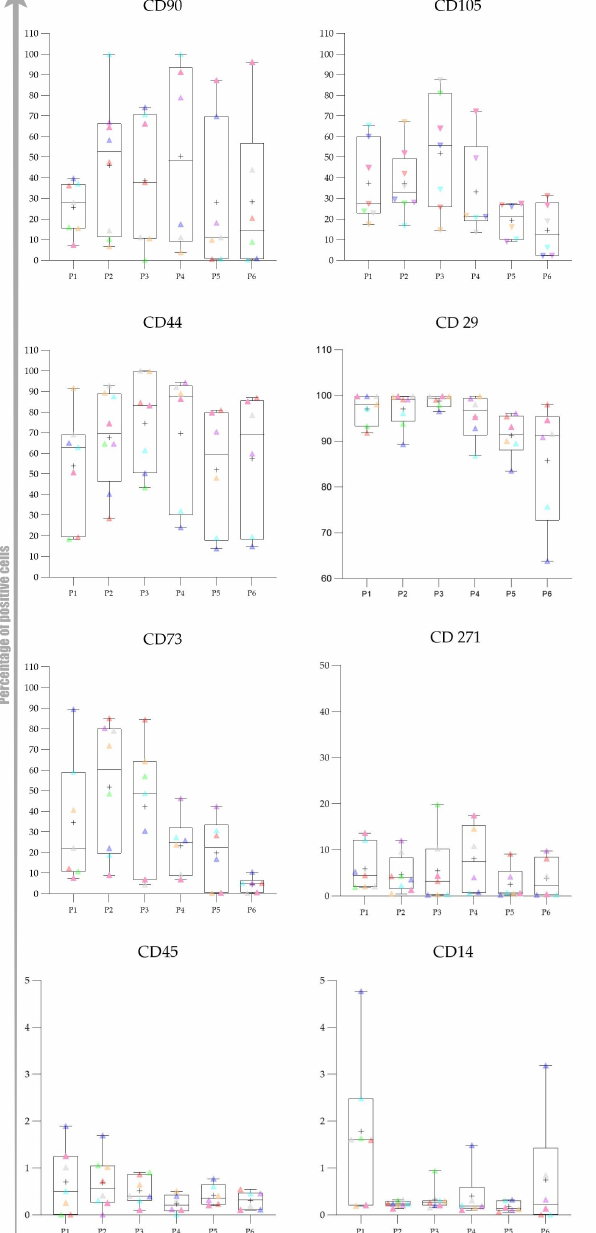
Figure 5. Changes in the percentage of positivity of canine adipose-derived mesenchymal stem cells (cAD-MSCs) during in vitro cultivation. The results are based on eight biological replicates, young female canines referred to an elective surgery procedure with no obvious signs of disease. Flow cytometry assessment of surface marker positive cAD-MSCs showed no statistically significant changes in the percentage of positive cells for the following markers: CD90, CD44, CD29, CD105 and CD271. Statistically significant changes were observed for CD73 between early (P1–P3) and late (P4–P6) passages. The X -axis represents the passage number (from P1 to P6), whereas the Y -axis displays the average positivity percentage. The Whisker box plot was created to present the dynamics of changes between passages. Centerlines denote the median, plus the mean, box limits indicate the twenty-fifth and seventy-fifth percentiles; whiskers represent the maximum and minimum of the average positivity percentage. Individual values are shown in colours to reveal changes for each donor included in the study. Donor 4/20 is presented in light pink, 5/20 in red, 6/20 in green, 7/20 in light blue, 8/20 in purple, 9/20 in orange, 11/20 in grey and 13/20 in dark